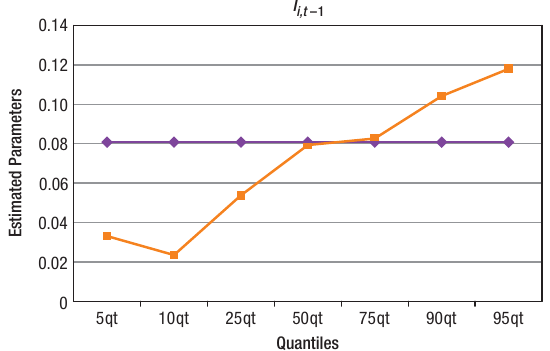
Fig. 8. Estimated parameters of relationship between I Notes: 1. The linear relationship represents OLS regression. 2. The non-linear relationship represents quantile